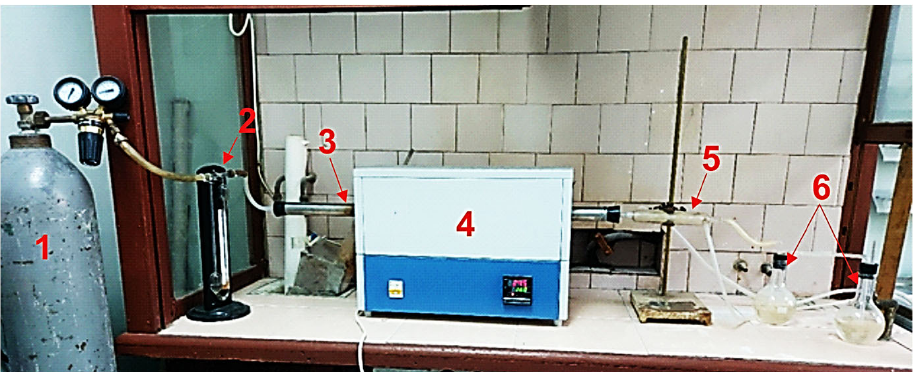
Figure 2. Assembly for laboratory research on fluoroammonium processing of electric melting ilmenite concentrate dust: 1—cylinder with argon, 2—flow meter, 3—pipe with alundum boat and sample, 4—horizontal furnace, 5—water-cooled refrigerator-condenser, and 6—gas trap system (10% NH 4 OH solution).